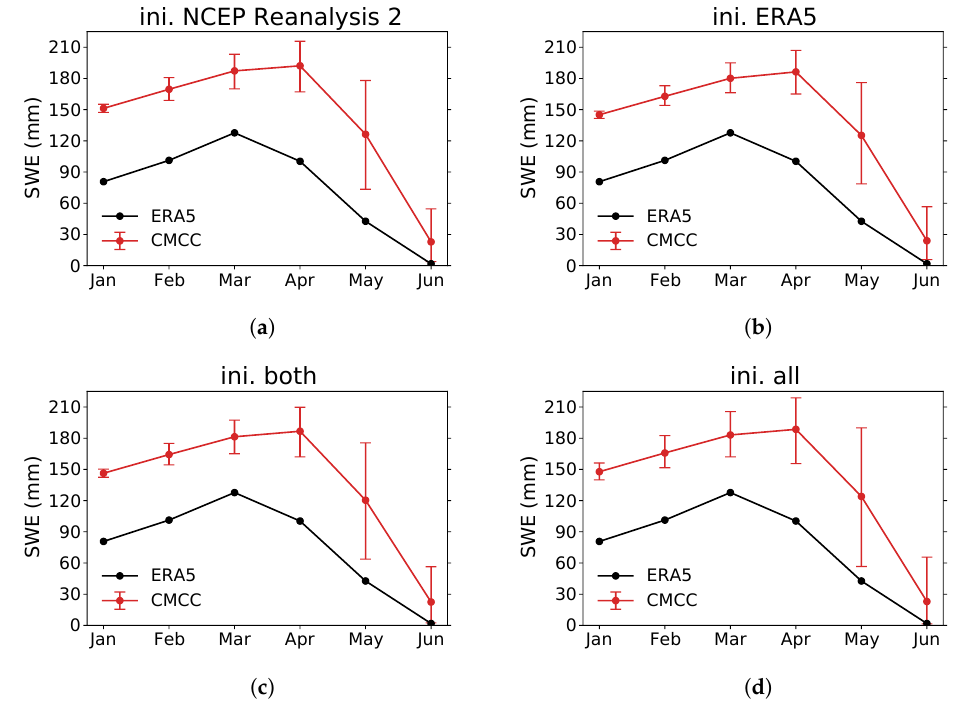
Figure 3. Average monthly SWE from 1993 to 2016 over Siberia from ERA5 (black) and CMCC (red). The red line represents the ensemble mean, and bars show the ensemble minimum and maximum averaged over the years and region. Panel ( a ) shows the sub-ensemble where only NCEP Reanalysis 2 was used to generate the indirect land initial conditions; ( b ) where only ERA5 was used; ( c ) a linear combination of both; and ( d ) the whole ensemble (sum of the previous).